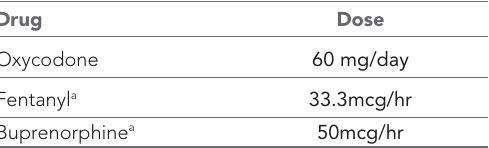
Table 1 Doses equivalent to 120mg/day of oral morphine. Calculated using the 'traditional' conversion tables produced by Palliative Care Guidelines Plus.